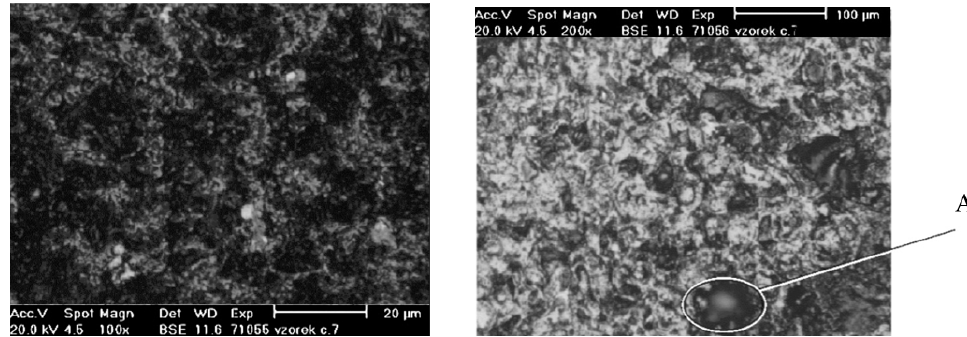
Figure 9. Microstructure of the Cr 2 O 3 coating. A—pull.